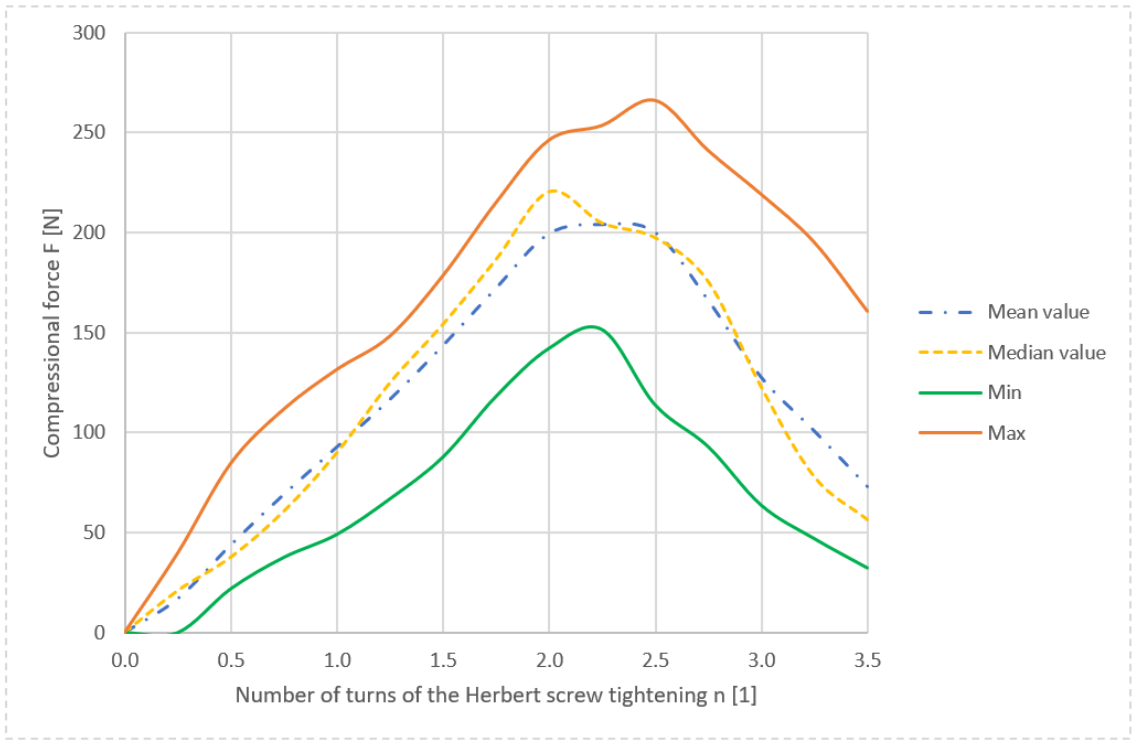
Figure 14. The statistically processed association between screw tightening and axial force.